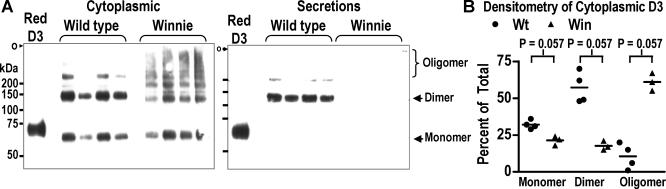
Altered Muc2 N-Terminal Oligomerisation Caused by the Win Mutation(A) PAGE/Western blotting analysis of oligomerisation of the rMuc2-D3 wild-type proteins and proteins with the Win mutation in MKN45 cells and secretions following transfection (n = 4 separate transfections for each group). The position of the origin (o) and markers are shown. A reduced sample (D3 Red) on each gel shows the migration of the D3 monomer. Recombinant proteins were detected with the M2 anti-FLAG antibody, and no reactivity was seen with untransfected cells. Note the hyperoligomerisation of the Winnie D3 domain intracellularly and its failure to be secreted.(B) Densitometric analysis of oligomerisation of the rMuc2-D3 Winnie and wild-type proteins in MKN-45 cellular lysates following transfection. Relative expression of monomer, dimer, and higher-order oligomers was determined by densitometry and expressed as a percentage of the total densitometric value for each sample (lane).Statistics: individual data points and p-values from Mann-Whitney U-tests shown.